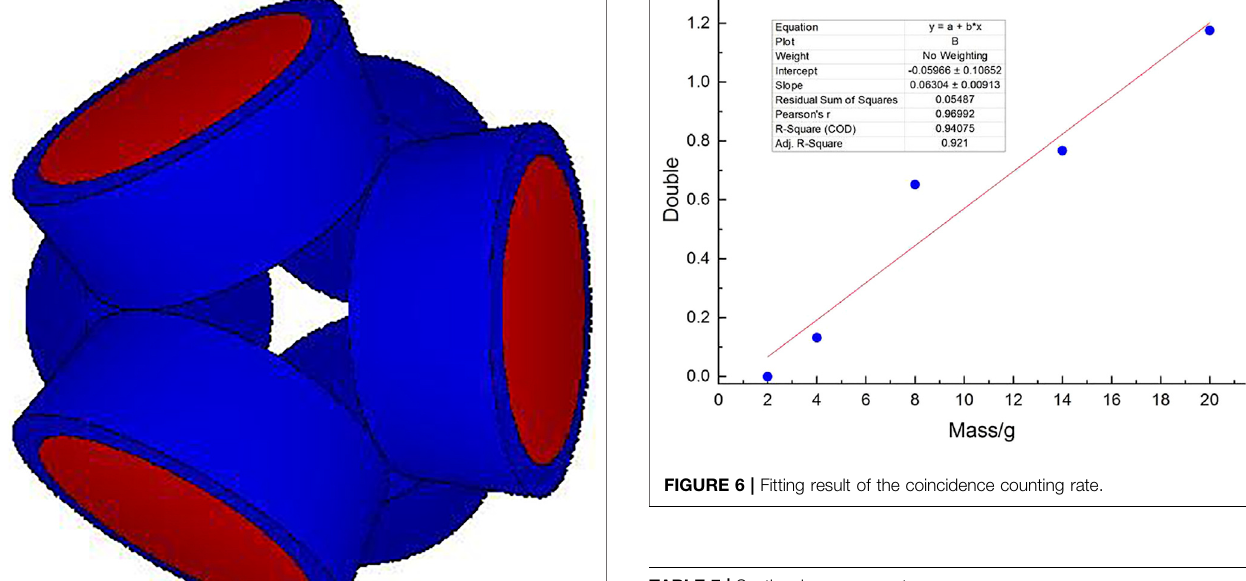
TABLE 7 | Sectional energy spectrum.